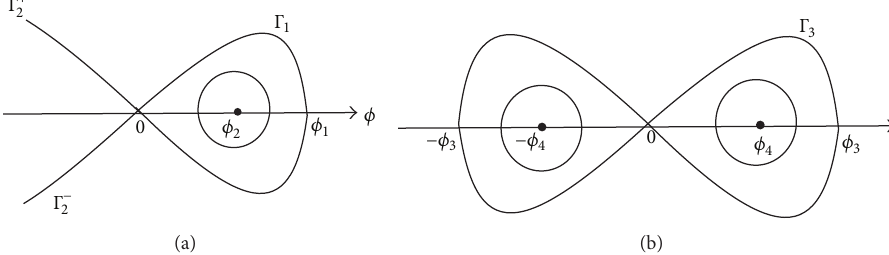
Figure 2: The phase portraits of Sy. (16). (a) For 𝑝 < 𝑞 , 𝑝 − 𝑞 is odd and 𝑐 > 0 . (b) For 𝑝 < 𝑞 , 𝑝 − 𝑞 is even and 𝑐 > 0 .